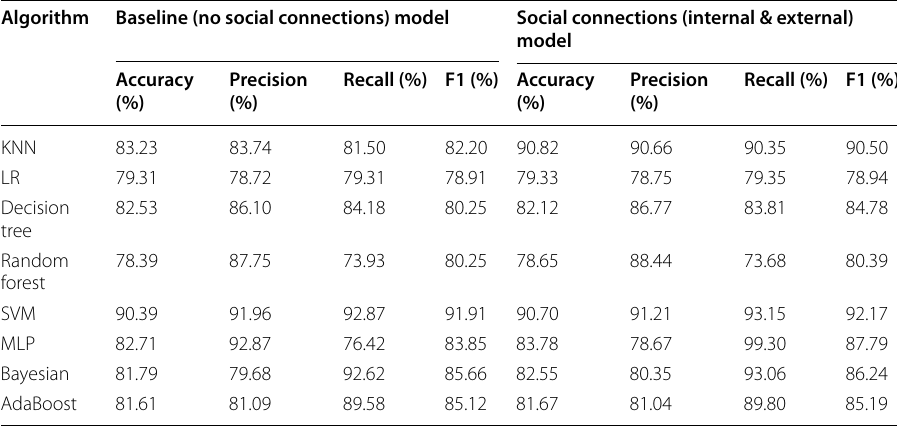
Table 8 Predictive power of internal and external social connections